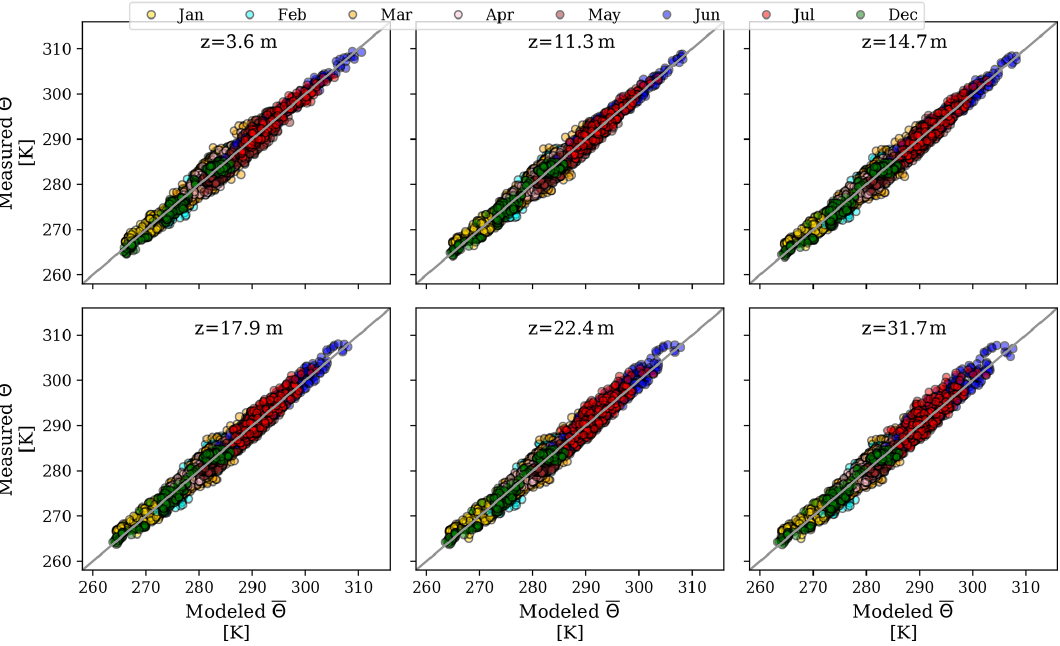
Figure 3. Scatter plots of observed (BUBBLE) versus simulated (VCWG) values of potential temperature for different altitudes and months; each data point corresponds to a 1h comparison between the model and observation. Table 2. Bias (K), RMSE (K), and R 2 (–) for VCWG predictions of potential temperature against the BUBBLE observations for different altitudes and